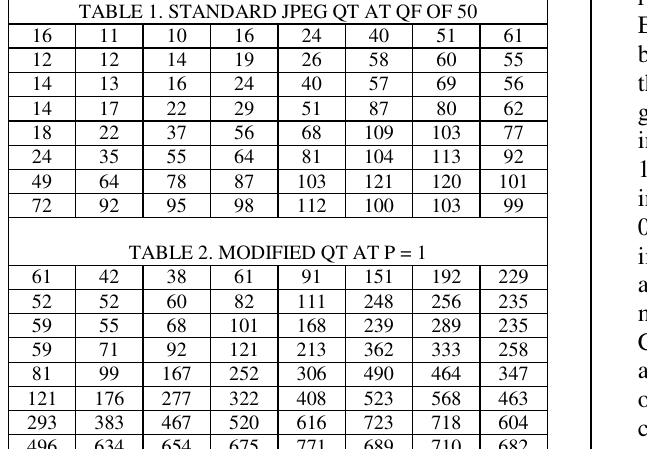
TABLE 1. STANDARD JPEG QT AT QF OF 50 16